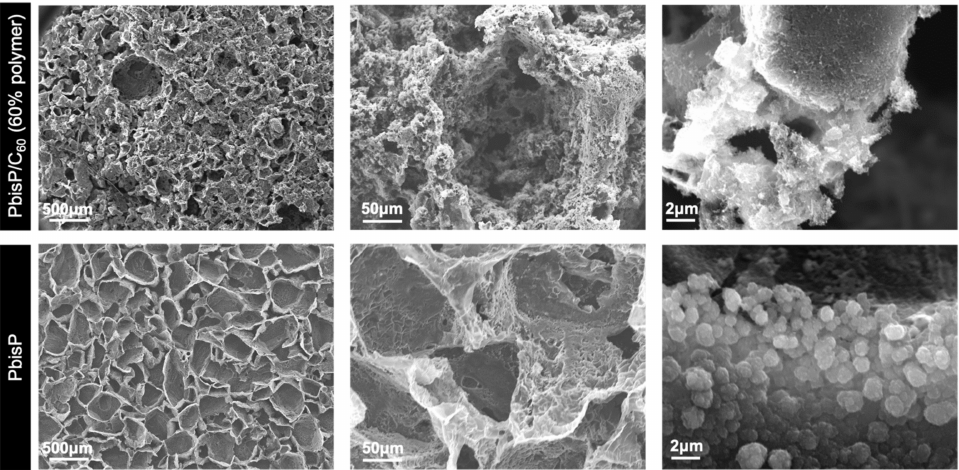
Figure 7. SEM images of the PbisP/CNT scaffolds with 60% of polymer content (top) and PbisP (bottom) after sucrose removal. Synthesis conditions: 1.2 V, 0.2 M of bisEDOT, and 2 h of